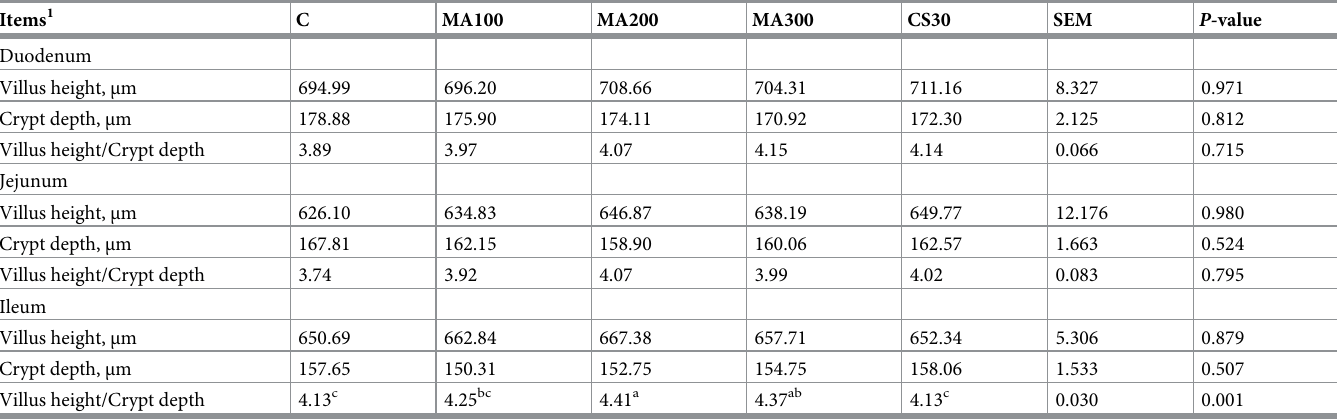
cose and total protein levels in this study (Table 5). MA200 significantly increased the serum Table 4. Effects of dietary magnolol at different levels on the intestinal mucosal morphology of 28 d Linwu